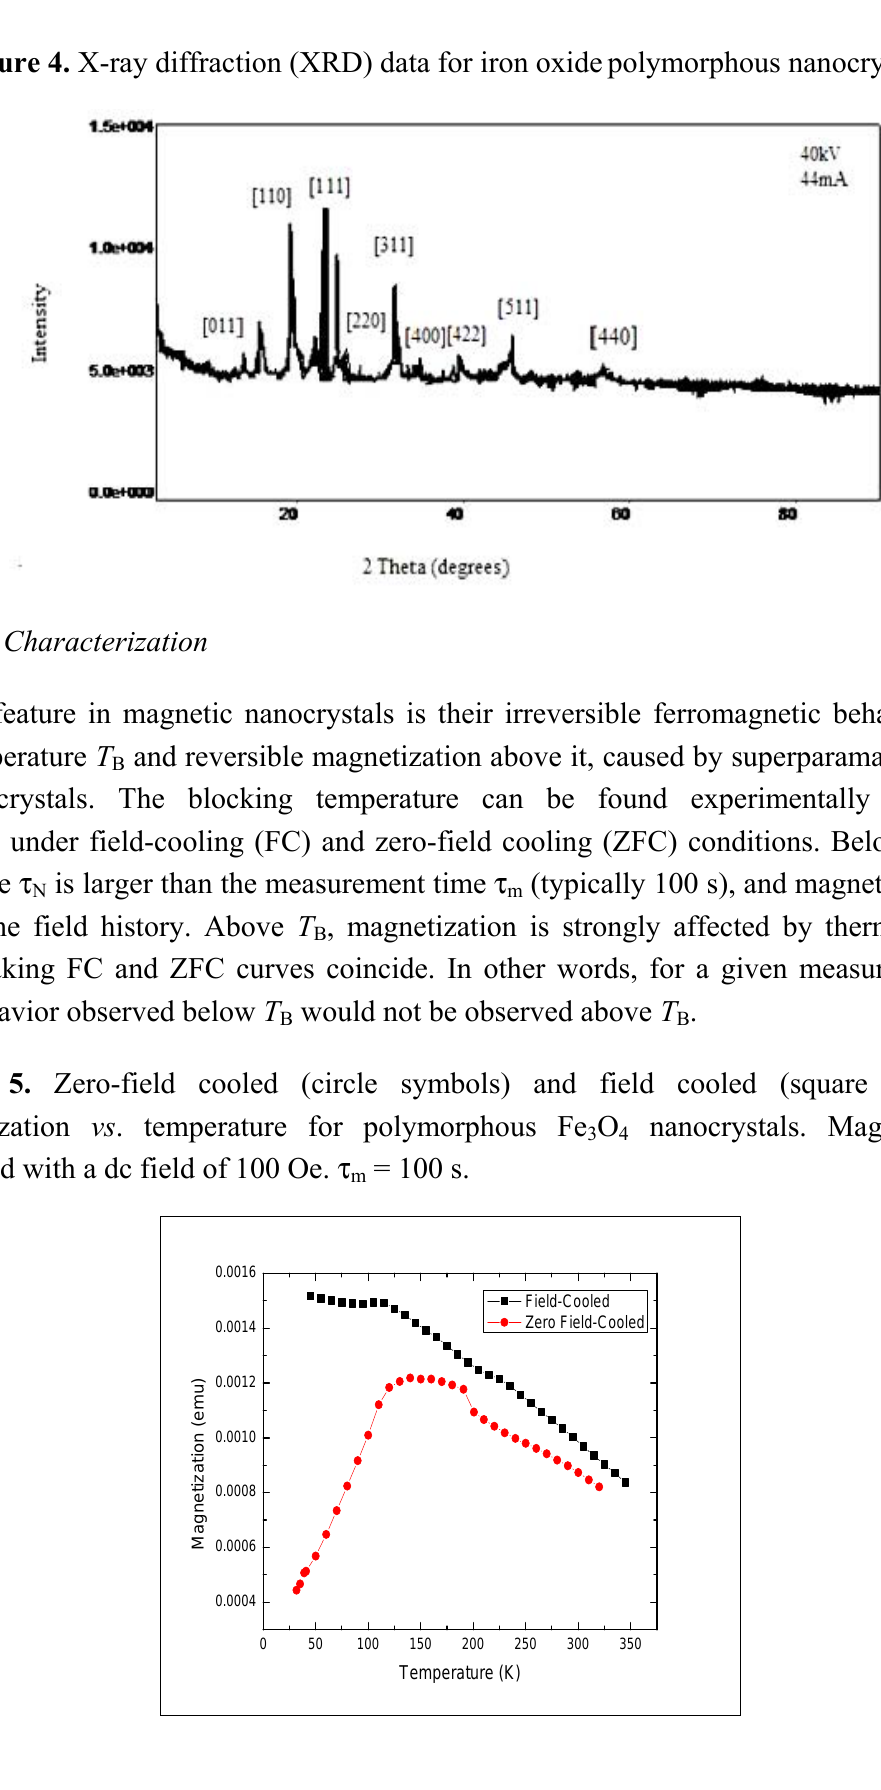
Figure 4. X-ray diffraction (XRD) data for iron oxide polymorphous nanocrystals.